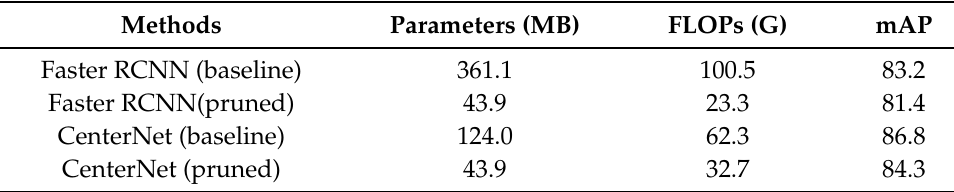
Figure 13. Performance on edge cases. Table 6. Comparisons with different detectors on NWPU